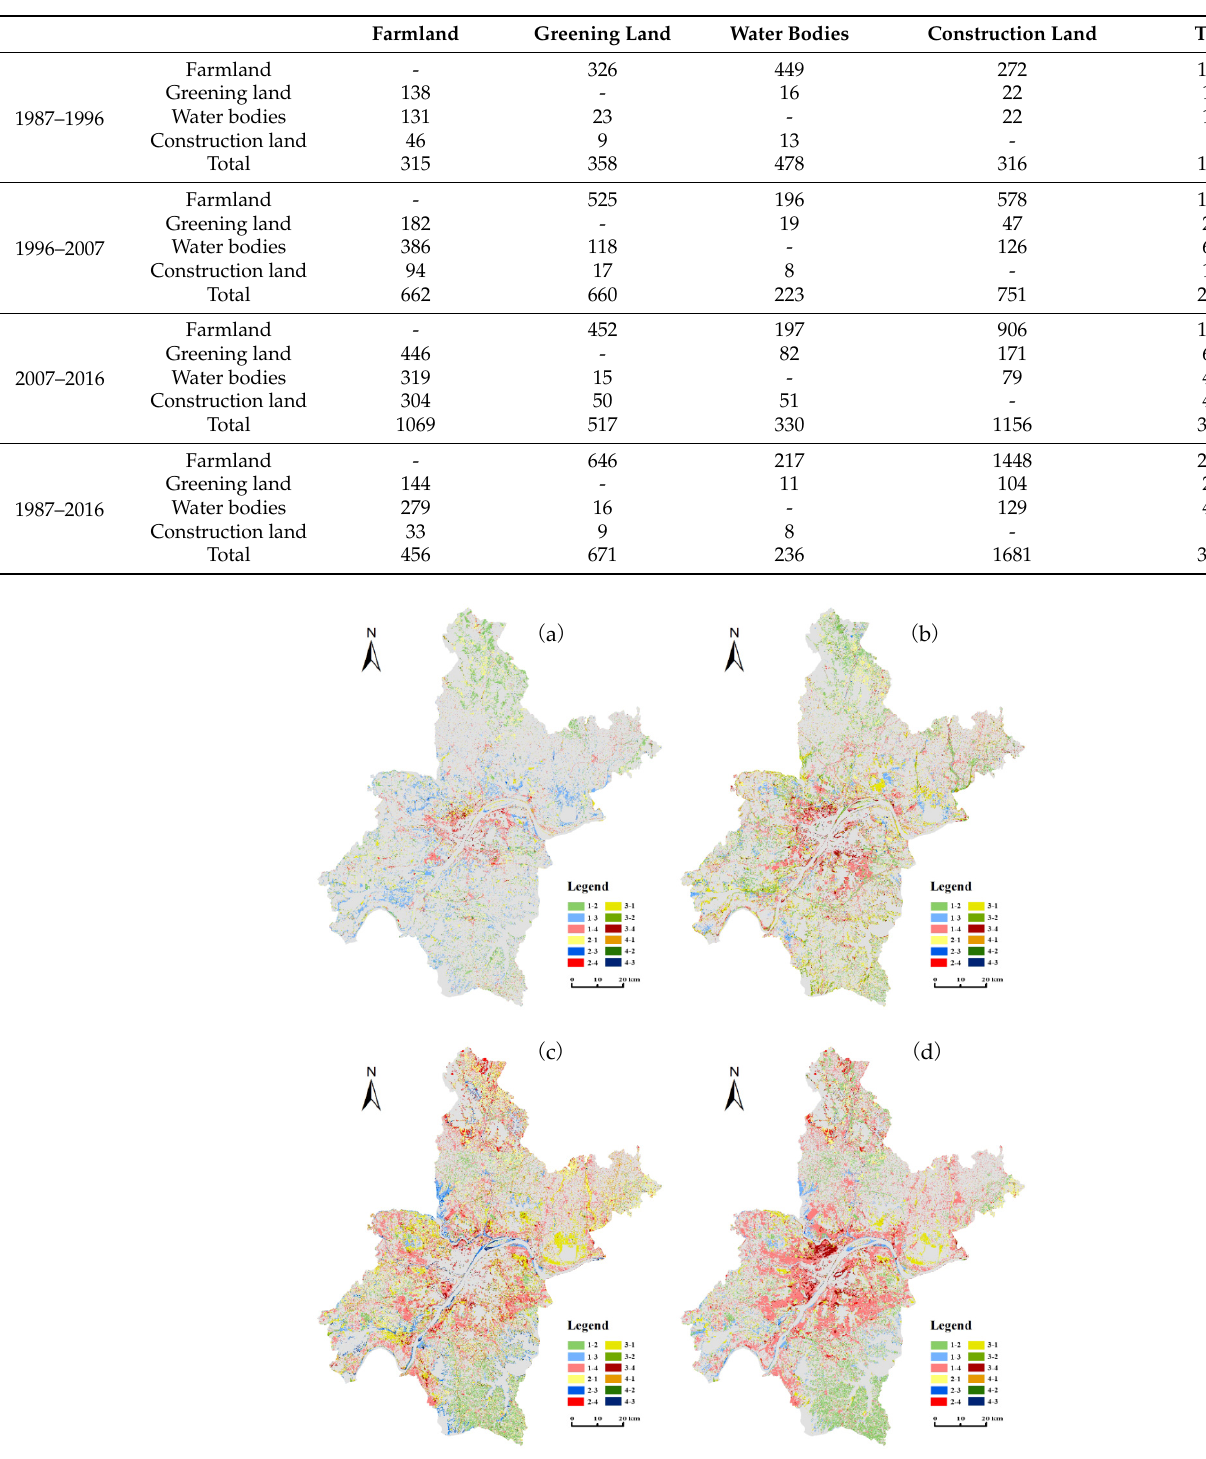
Table 2. Transfer matrix among different LULC types during 1987–2016 in Wuhan.